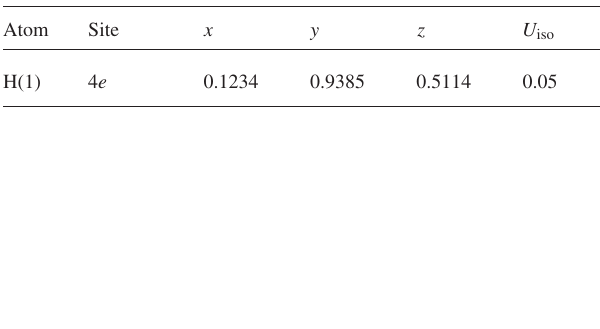
Table 2. Atomic coordinates and displacement parameters (in Å 2 ) . Table 1. Data collection and